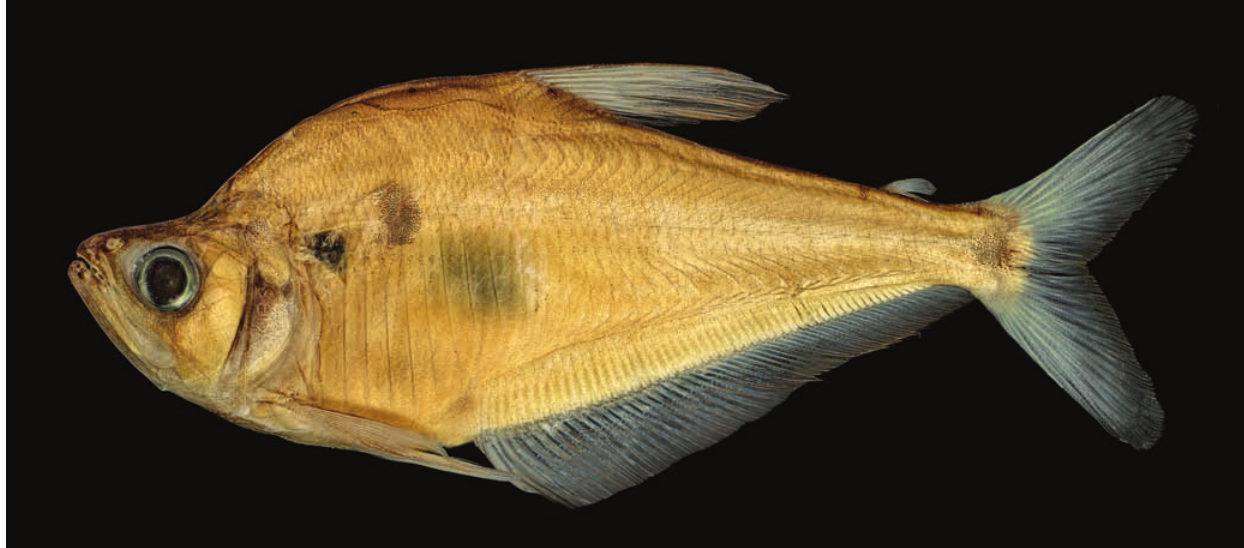
Fig. 15. Charax macrolepis , MZUSP 28730, female, 93.5 mm SL, Brazil, Amazonas, tributary of rio Guaporé, 30 km above Vila Bela da Santíssima Trindade.